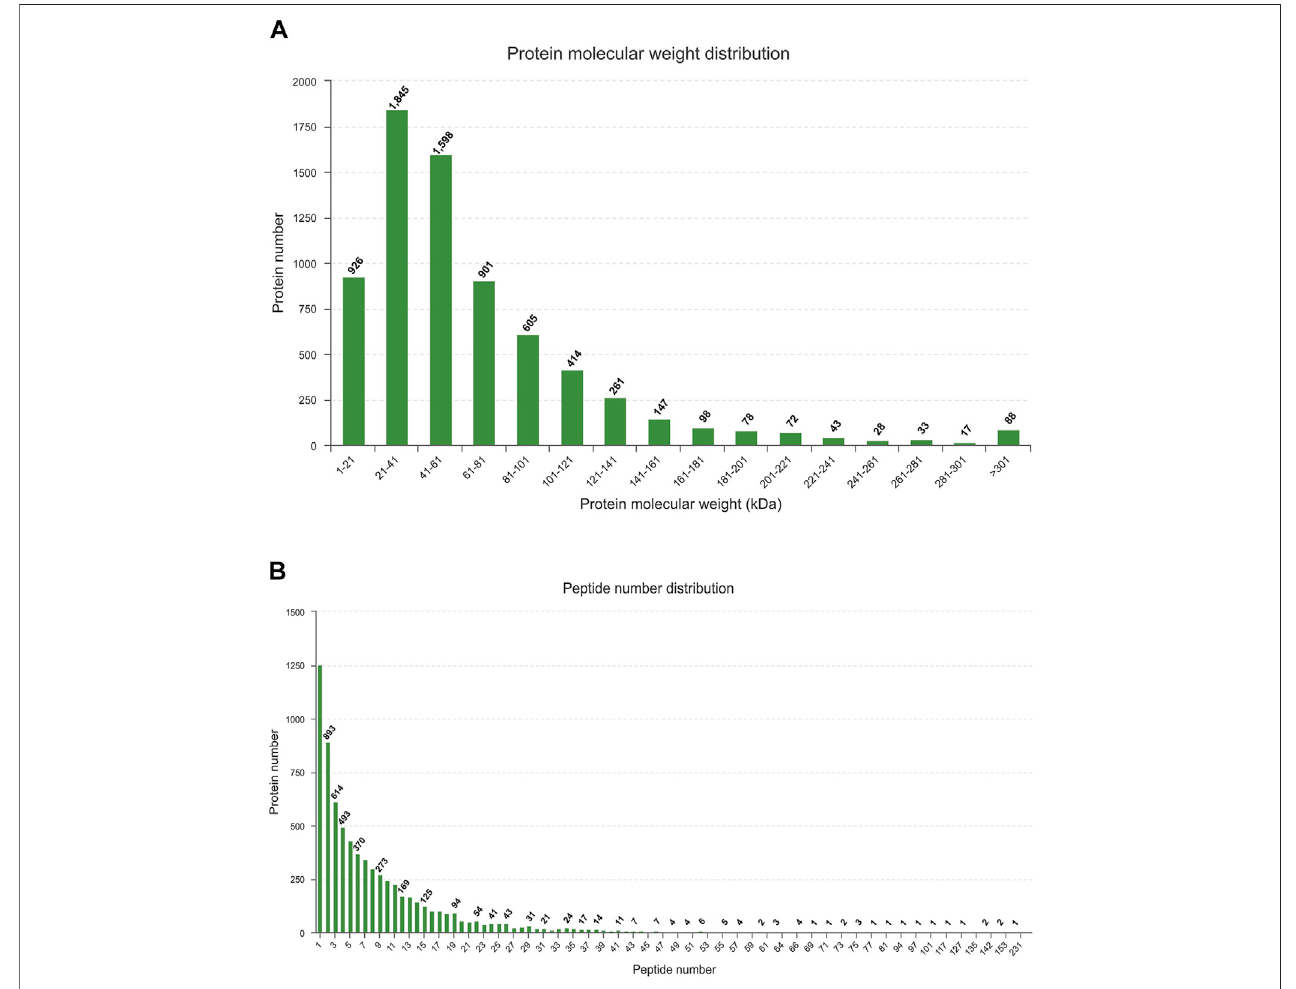
FIGURE 3 | Identi fi cation and analysis of proteins (A) Distribution of the identi fi ed proteins among different molecular-weight classes. (B) Distribution of proteins containing different numbers of identi fi ed peptides.